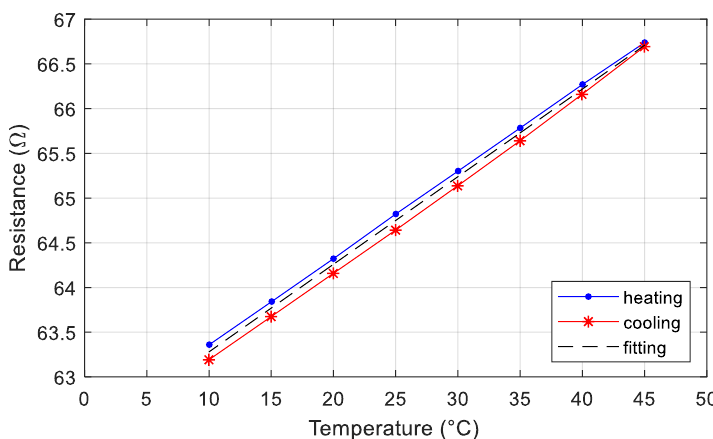
Figure 7. Resistance of the strain sensor printed on a PVC conduit over temperature. The blue line is obtained by increasing the temperature, whereas the red one is obtained by decreasing the temperature. The black dashed line best fits five repeat experiments and it is calculated by using the linear least squares (LLS) method.